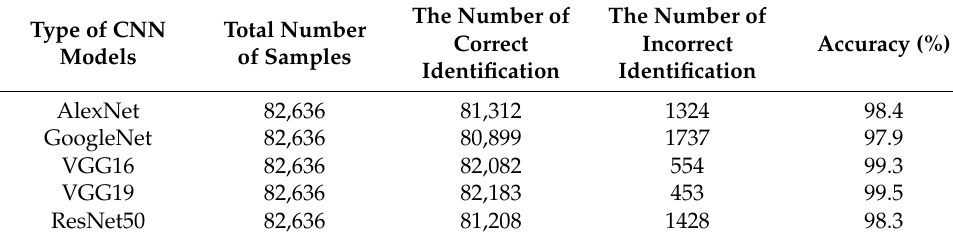
Table 3. The recognition results in the CNN test set.